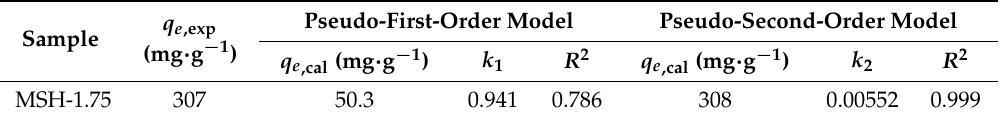
Table 2. Pseudo-first-order and pseudo-second-order adsorption kinetic constants for MB